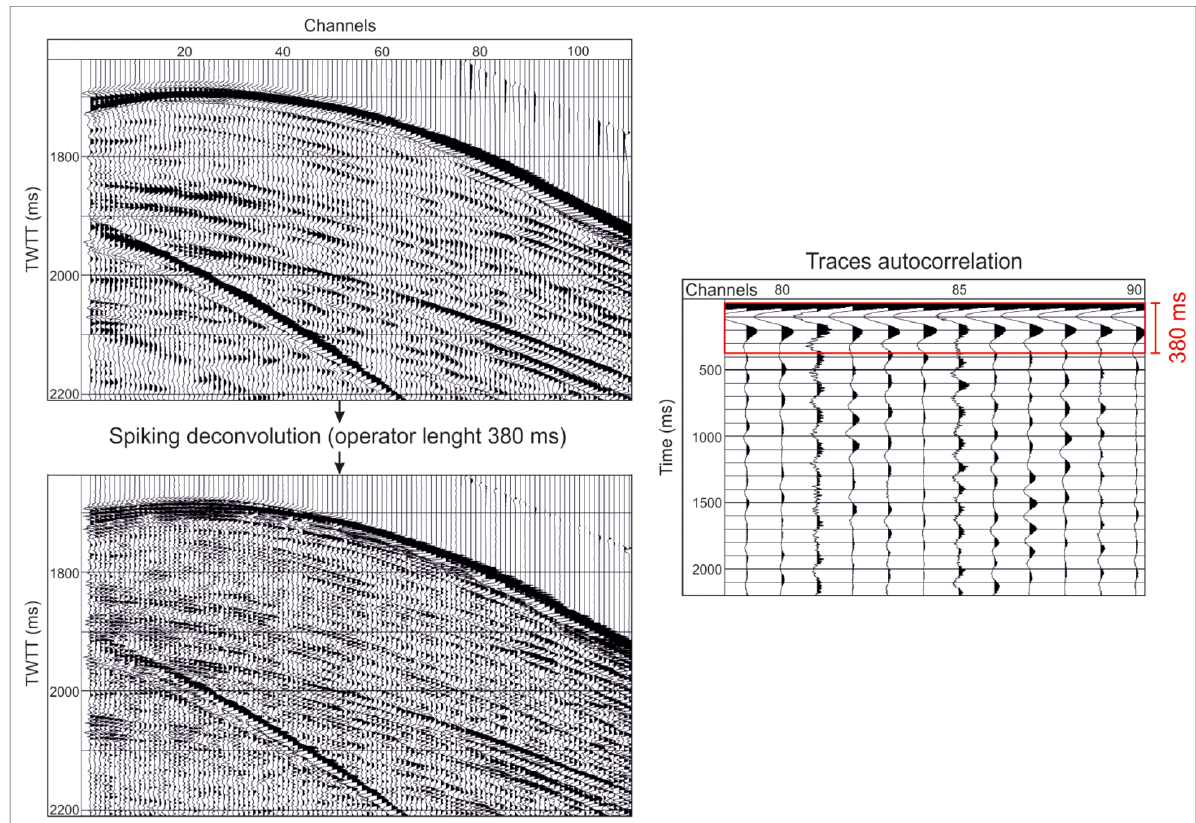
Figure 8. Effects of spiking deconvolution (bottom) on one pre-processed shot (top) of the line L_08_MCS (Ionian Sea), using an operator length of 380 ms. Note the sharpen arrivals of the main reflectors (see text for further